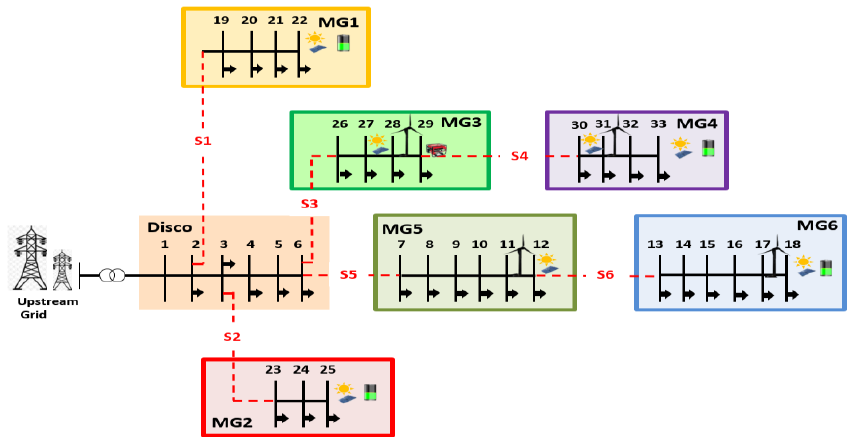
Figure 3. Proposed idea of energy-sharing and DR in microgrids.